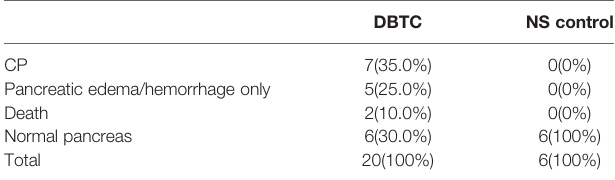
TABLE 2 | Statistical results of CP animal model.